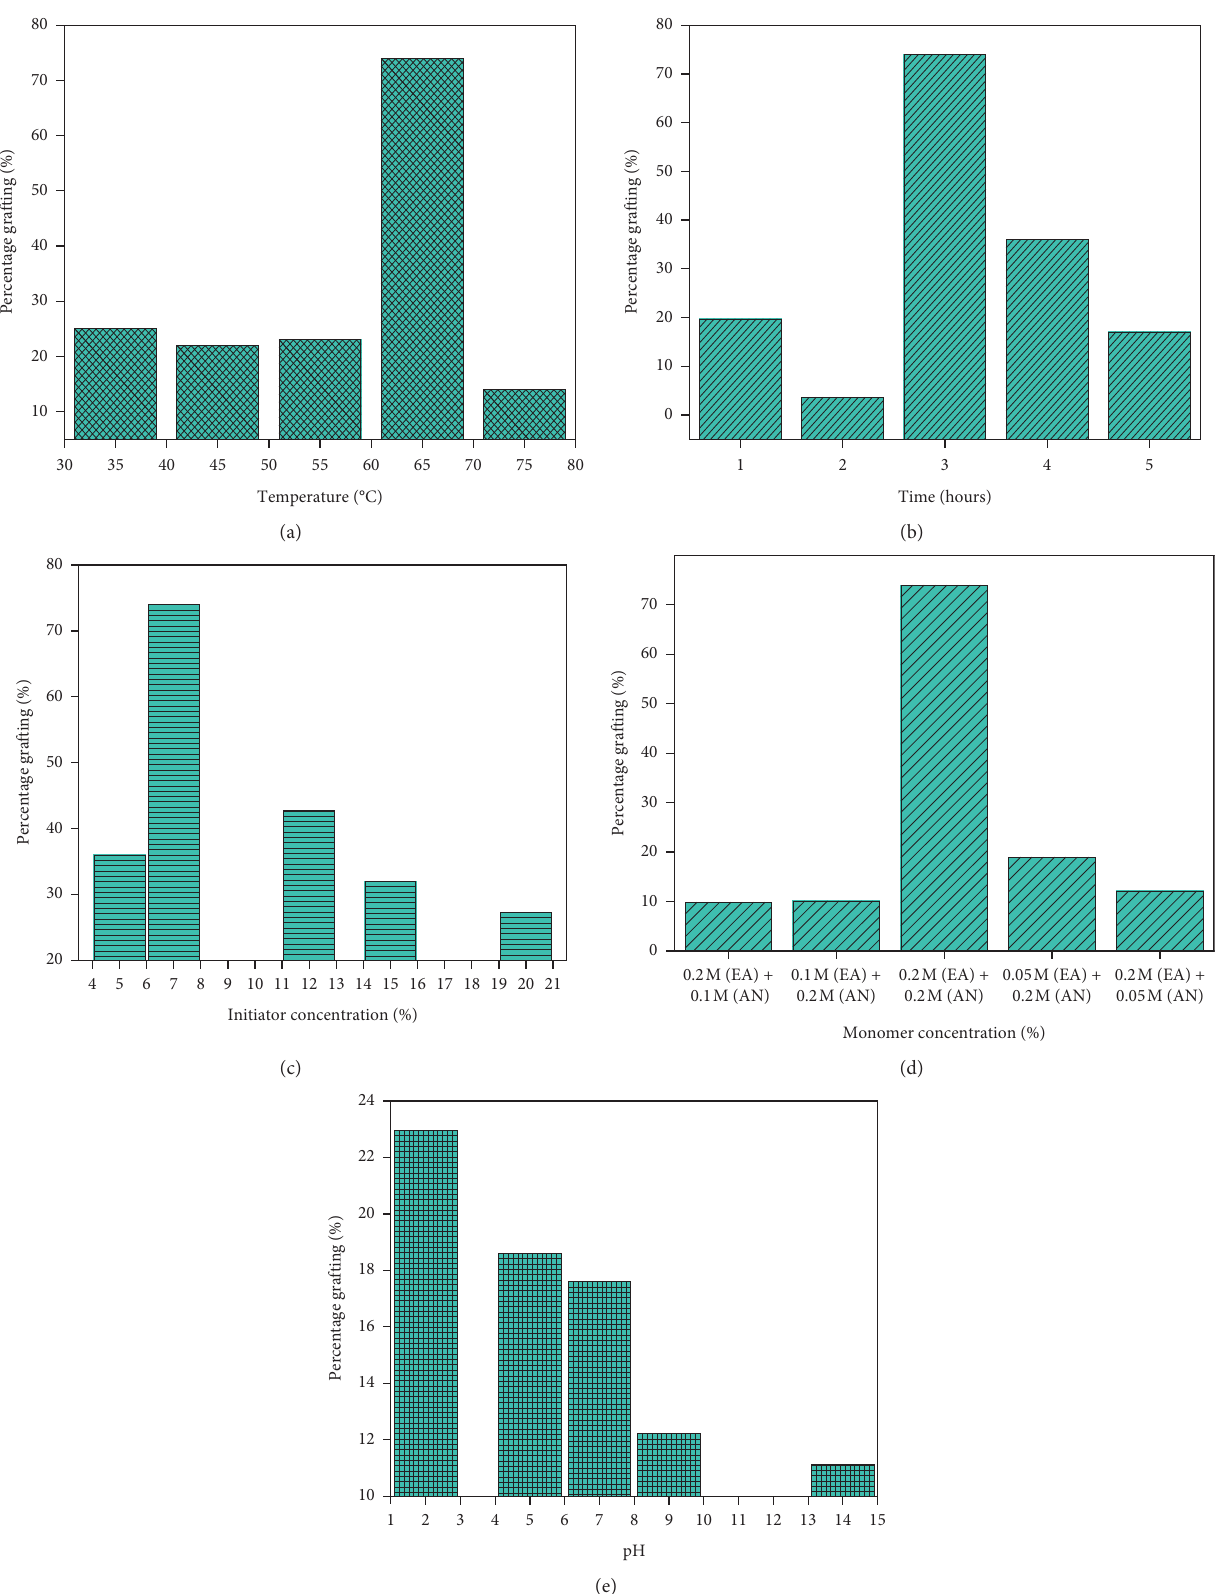
Figure 4: Optimization of reaction parameter for pinus-g-(AN/EA). (a) Temperature. (b) Time. (c) Initiator concentration. (d) Monomer concentration. (e)